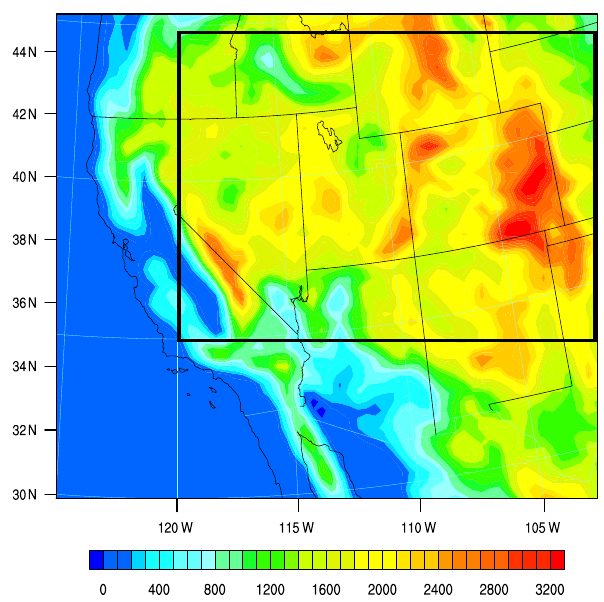
Fig. 1. The elevation map over a 30km resolution grid for the Rocky Mountains and Sierra Nevada areas in the western United States. Fig. 1 The box on the map displays major mountainous areas where sim- ulation results are analyzed and presented in the